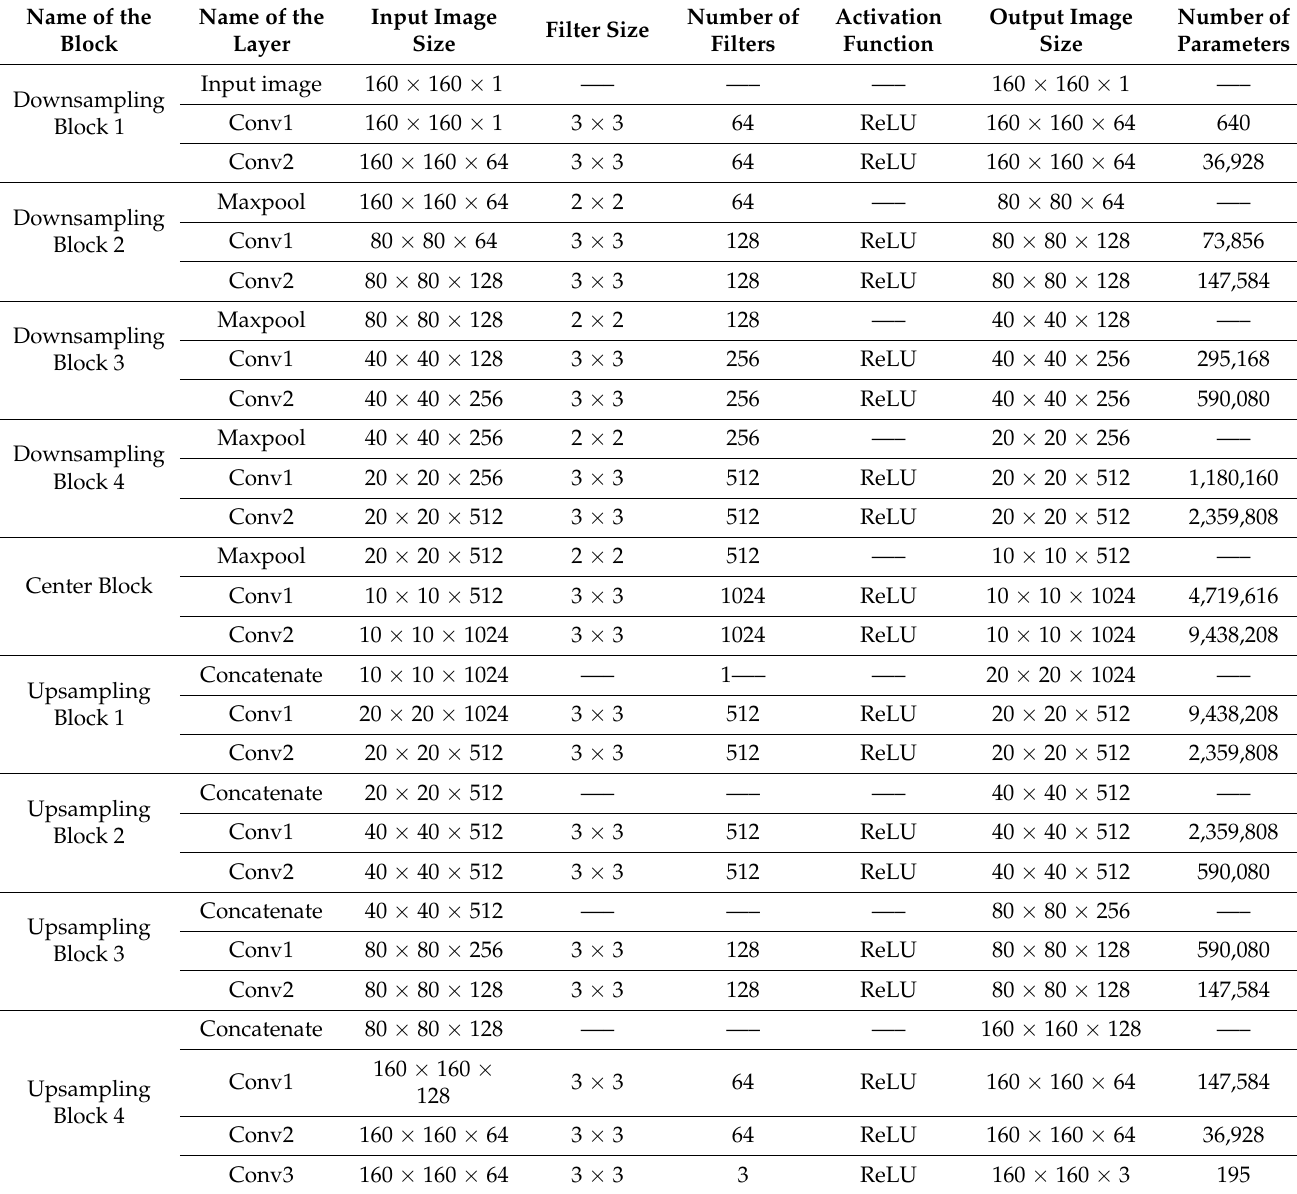
Table 1. Model Summary of the Proposed U-Net